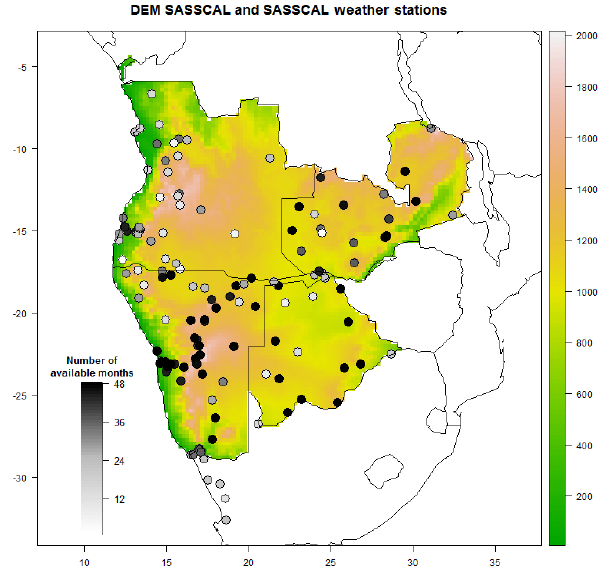
Figure 1. Digital elevation model (color coded) for the study area. Circles show the location of the SASSCAL Weathernet stations. The circle filling illustrates the data availability from black for data completely available over the whole period to empty circle for no data available for the